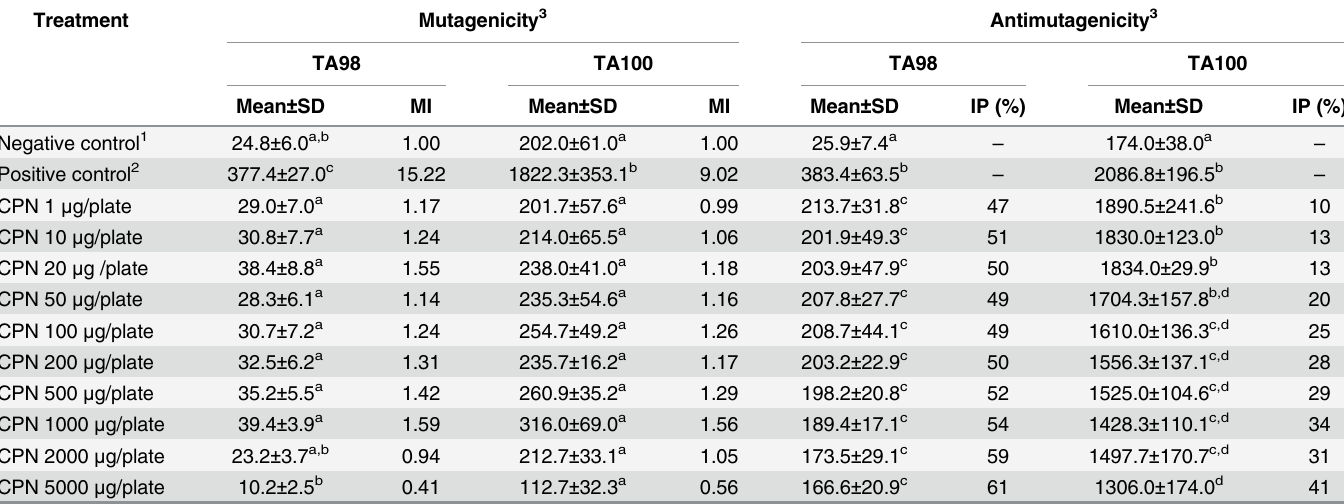
Table 2. Means ± standard deviation (SD) of histidine revertant colonies, mutagenic index (MI), and inhibition percentage (IP) of mutagenicity for two tester strains of Salmonella typhimurium , TA98 and TA100, after treatment with different doses of sulfonamide chalcone